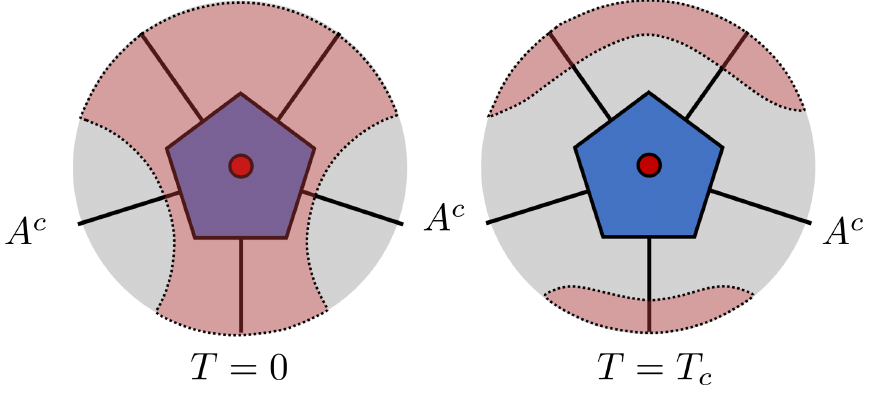
Figure 13 . The perfect code as a mini-holographic code. The area shaded in red marks the portion of bulk cut out by end-of-the-world branes after a projective measurement is performed on subsystem A . We distinguish the analogous zero tension vs critical tension configurations on whether the bulk qubit has been teleported to A c